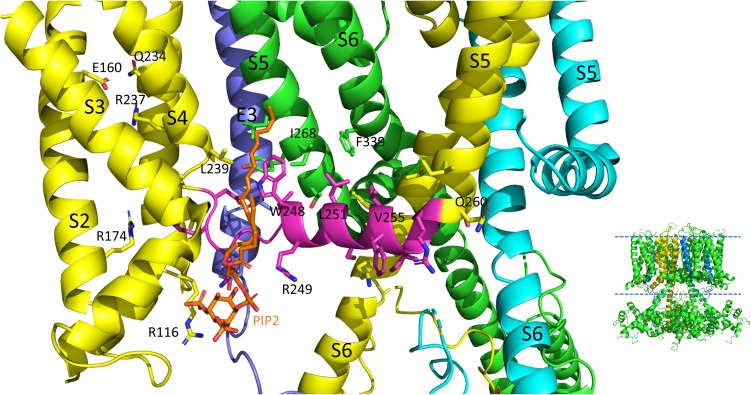
S4-S5L interactions of the PIP2 bound hKCNQ1/KCNE3/CaM structure. Each of three subunits of the tetramer is shown in a different color. The S4-S5L of the yellow subunit is shown in magenta for emphasis. Side chains of residues of the S4-S5L and residues within 4Å of these are shown, in addition to E160, R237 and Q234 in the yellow subunit to emphasize the activated state of the VSD. Only some of the more visible side chains are labeled but all residues appearing to interact with the linker include: R116, R174, I198, L239, H240, V241, Q260, E261, L262, and I263 (yellow subunit); E261, Y267, I268, and L271 (green subunit); none (cyan subunit); L75 and Y79 (KCNE3); PIP2. CaM and most of the intracellular portions (illustrated in inset to right), as well as the VSD of the cyan subunit, a third entire subunit and all but one KCNE3 (dark blue) have been removed for clarity. Image made from pdb 6V01 (Sun and MacKinnon, 2020) using PyMOL software (The PyMOL Molecular Graphics System, Version 2.2.3 Schrödinger, LLC).